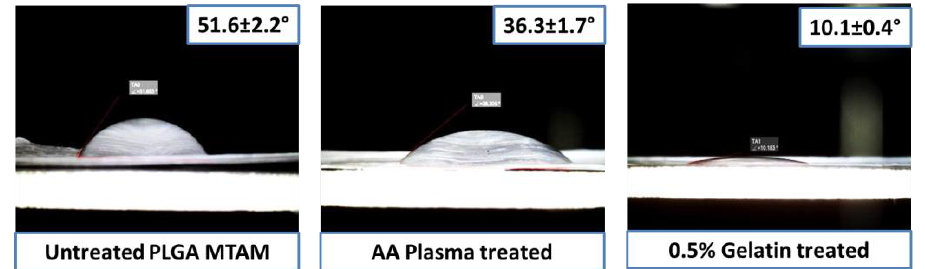
Figure 4. ddH 2 O contact angle of (left to right) untreated; AA plasma treated; and 0.5% treated PLGA MTAM. A significant reduction in water contact angle was recorded with the addition of surface treatment, which was followed by gelation coating.